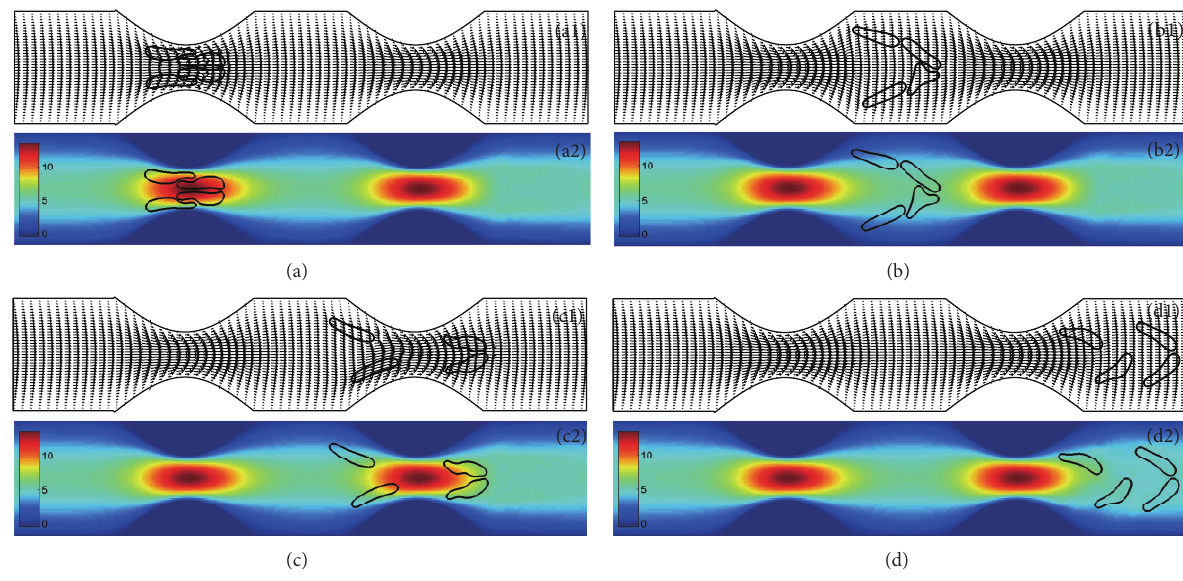
Figure 12: Motion and dissociation of a four-cell erythrocyte aggregate which is vertically placed in a 8 𝜇 m sinusoidal shaped stenosis at time instants (a) 𝑡 = 0.42 ms; (b) 𝑡 = 0.78 ms; (c) 𝑡 = 1.13 ms; and (d) 𝑡 = 1.46 ms. Velocity vectors (a1-d1) and axial velocity magnitude contours (cm/s) (a2-d2) are presented. The initial configuration for the aggregate is shown in Figure 1(c), and the aggregate is horizontally placed in the channel initially. The parameters used are 𝐷 𝑒 = 1.0 × 10 −2 𝜇 J/m 2 , 𝑘 𝑏 = 5.0 × 10 −13 Nm.